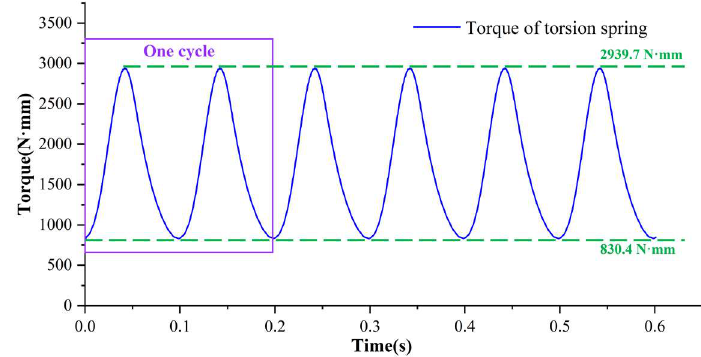
Figure 12. The curve of the torque of the torsion spring.